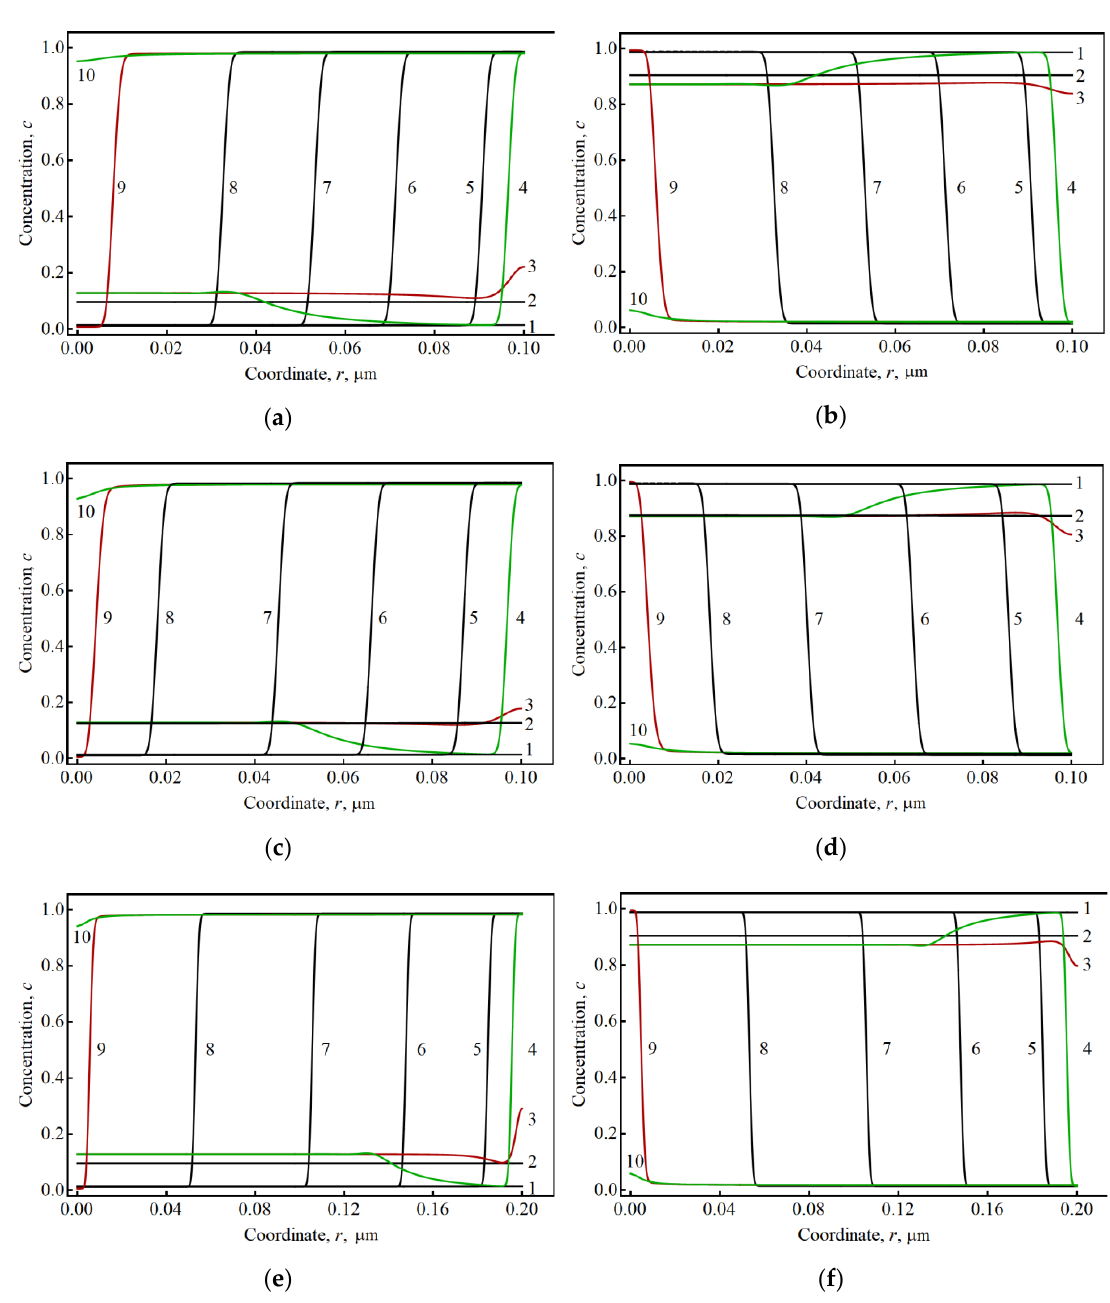
Figure 2. Concentration profiles of intercalating atoms for different time points at T = 300 K. Corresponding radius of particle and C -rate are: ( a ) 0.1 µm, 1C insertion, ( b ) 0.1 µm, 1C extraction, ( c ) 0.1 µm, 10C insertion, ( d ) 0.1 µm, 10C extraction, ( e ) 0.2 µm, 0.5C insertion, ( f ) 0.2 µm, 0.5C extraction. The lines 3, 4, 9 and 10 correspond to passing from single-phase stage to double-phase stage and vice versa.